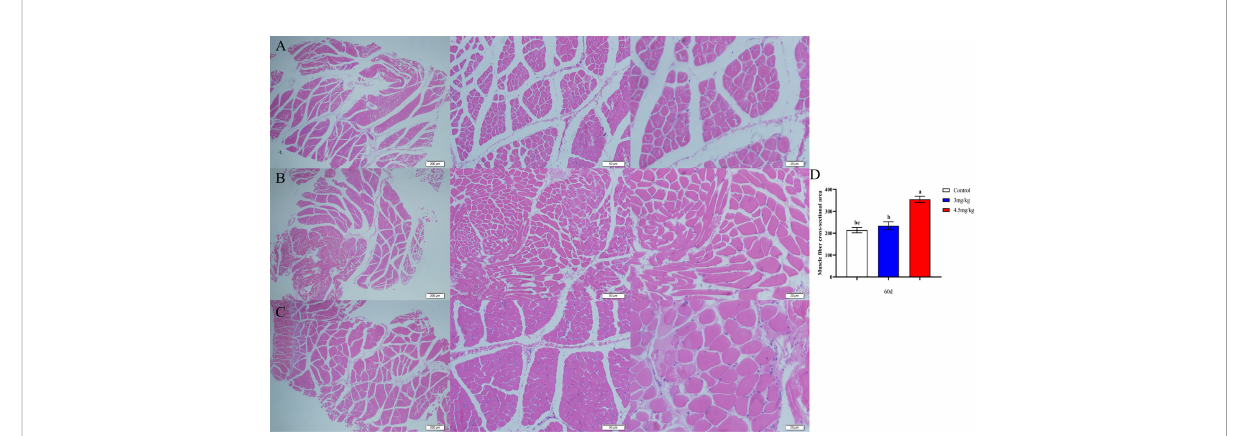
FIGURE 5 Cross-sectional muscle fi ber diagram of the back muscles. (A) The cross section of the longissimus muscle in control group, 200×, 50×, and 20×, respectively; (B) The transverse section of the longissimus muscle in 3mg/kg group, 200×, 50×, and 20×, respectively; (C) The cross section of the longissimus muscle in 4.5mg/kg group, 200×, 50×, and 20×, respectively; (D) Statistical analysis of the cross-sectional area of the longissimus dorsi. Different lowercase letters indicate P <0.05 vs control.